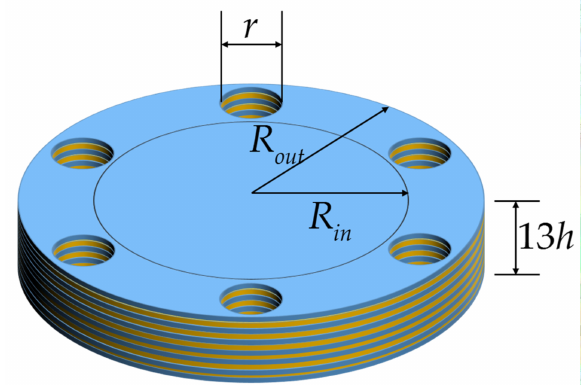
Figure 3. Geometry dimension illustration of the test laminate. (Blue colour represents 0 ◦ and yellow colour represents 90 ◦